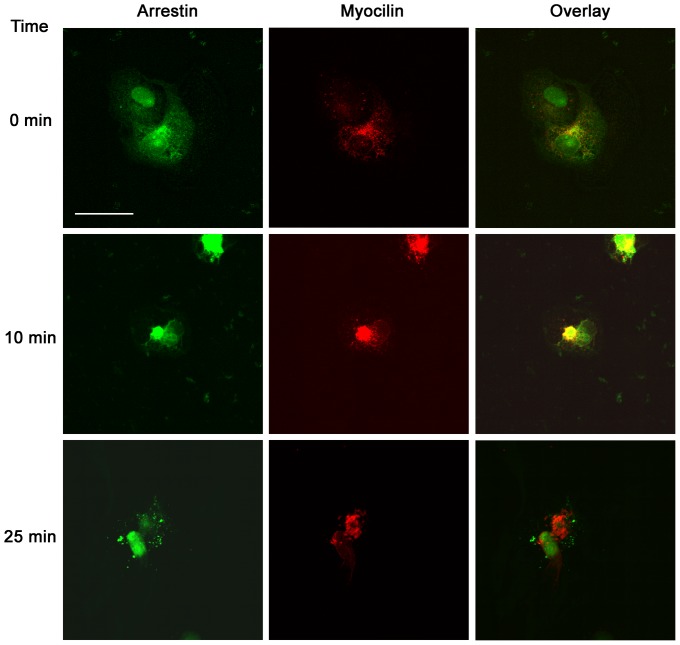
Co-localization of myocilin and arrestin 2.Confocal micrograph of arrestin 2 linked to GFP and myocilin observed by immunofluorescence at time 0, 10, and 25 minutes after l-DOPA treatment. The images are overlaid to illustrate co-localization at 10 and lack of co-localization at 0 and 25 minutes. Bar equalsµM.